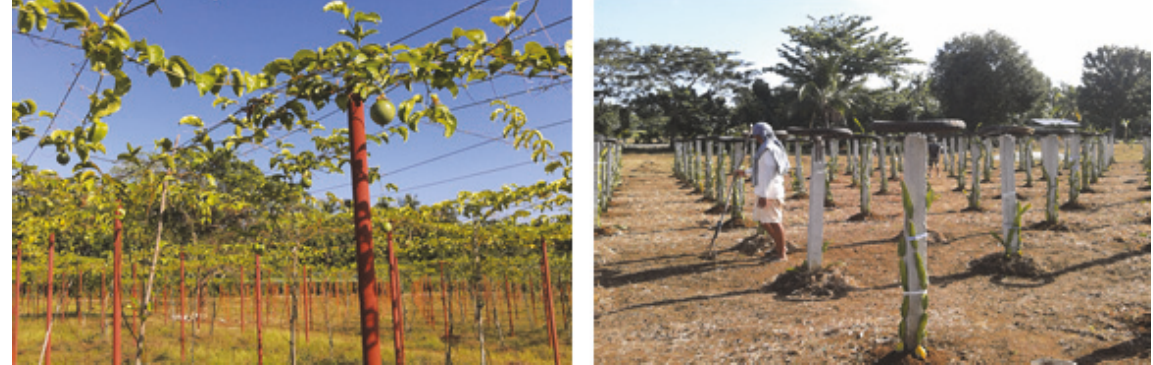
Figure 4: Passion fruit (left) and dragon fruit (right) plantations in Camotes, Cebu.